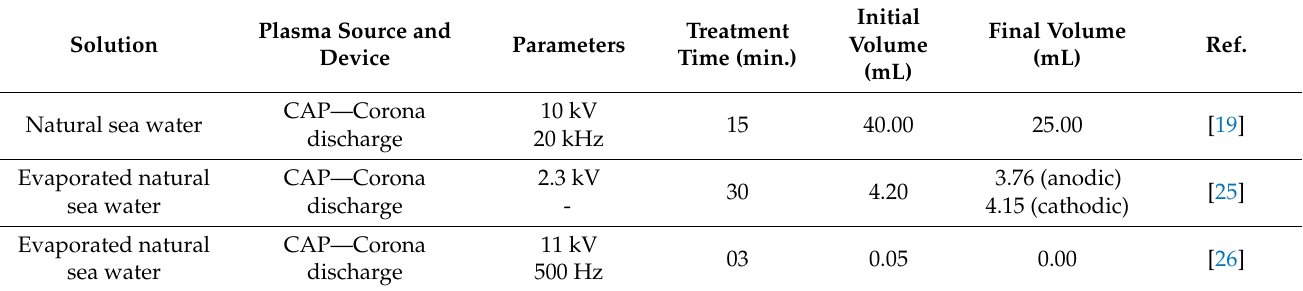
Table 5. Plasma-induced evaporation in saline